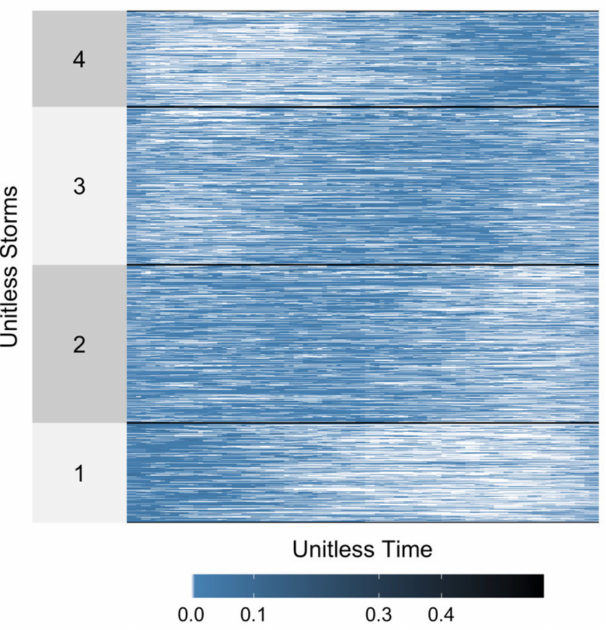
Figure 5. Unitless rainstorms values re-order by clustering results. The names of the clusters were used in order to match with Huff’s classification. White symbolizes zero precipitation depth, and different blues depict the presence of unitless